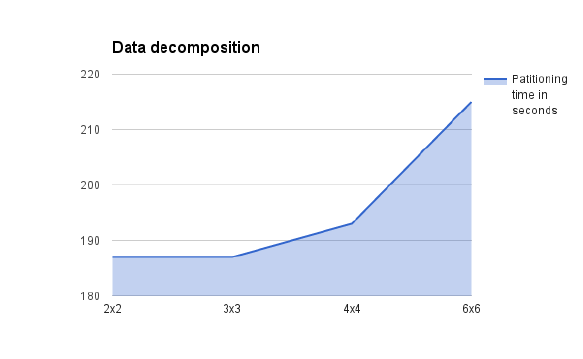
Figure 4: Data decomposition time increases after 4x4 grid size